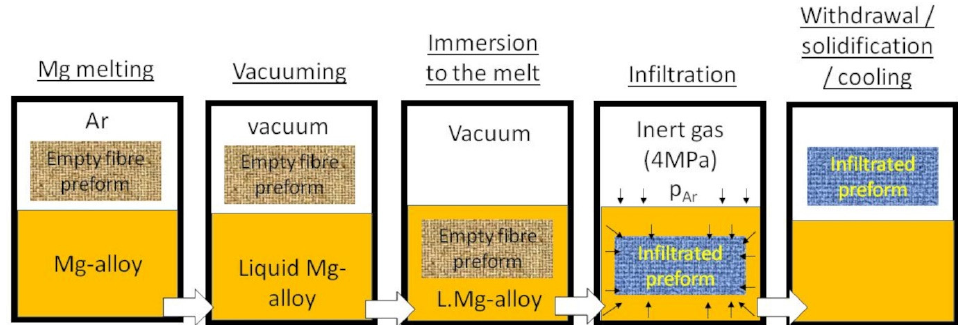
Figure 2. Schematic image of the gas pressure infiltration process.